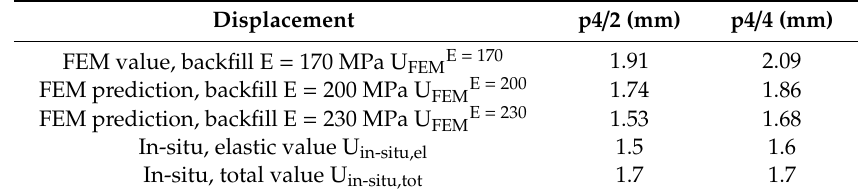
Table 3. Comparison of the in situ measured and estimated by means of FEM extreme displacements.